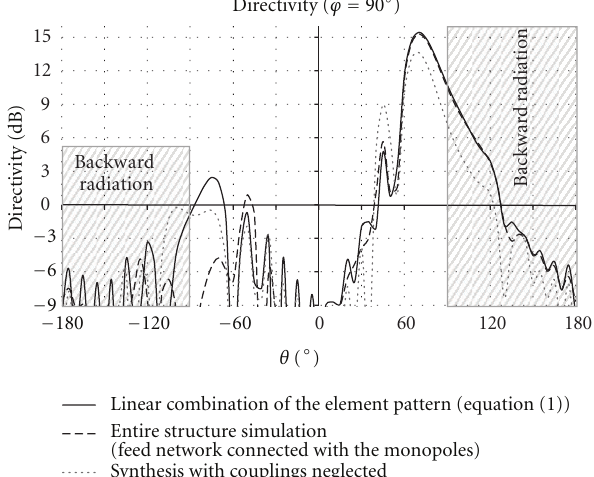
Figure 6: Synthesized radiation pattern with couplings and theo- retical linear combination of the monopole patterns (objective) at 5.60GHz. Results with couplings neglected are also presented.